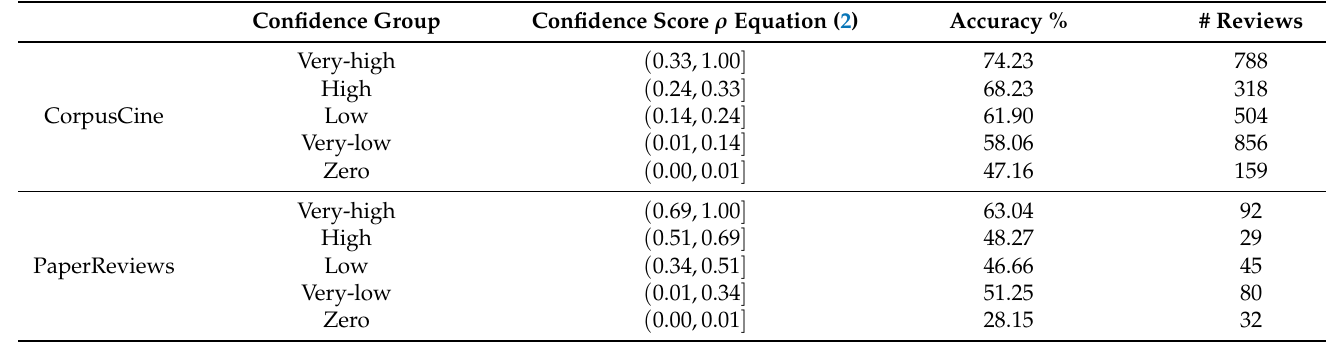
Table 4. Prediction accuracy of LRSentiA for the defined confidence groups (Equation (3)) in a machine- translated version of CorpusCine and PaperReview